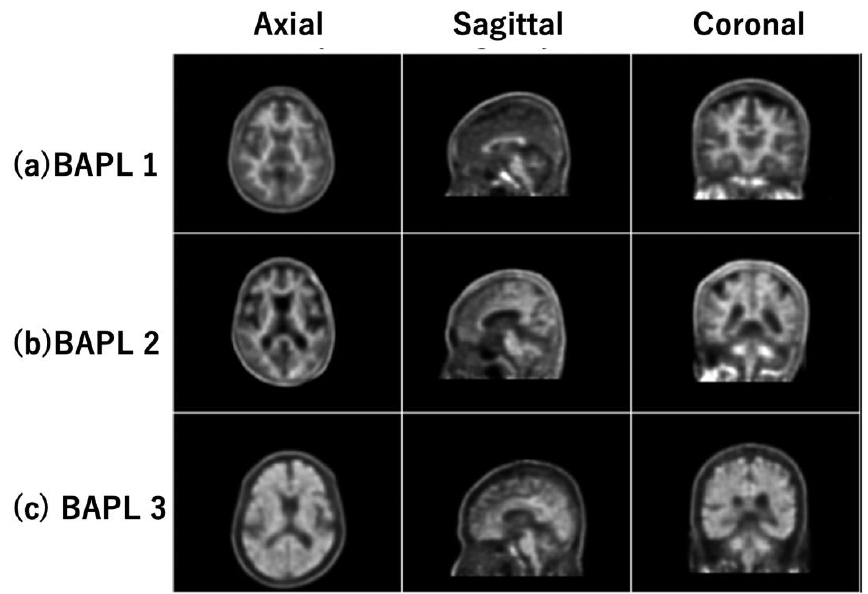
Figure 1. Typical central slice images of (a) BAPL1; (b) BAPL2; and (c) BAPL3.